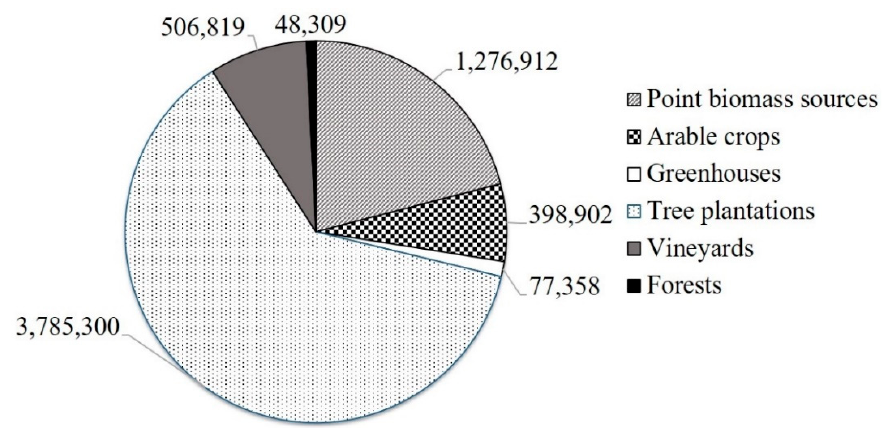
Figure 13. Total biomass energy potential in the Region of Peloponnese (in tonnes) by biomass source, 2010 [16,21,22].